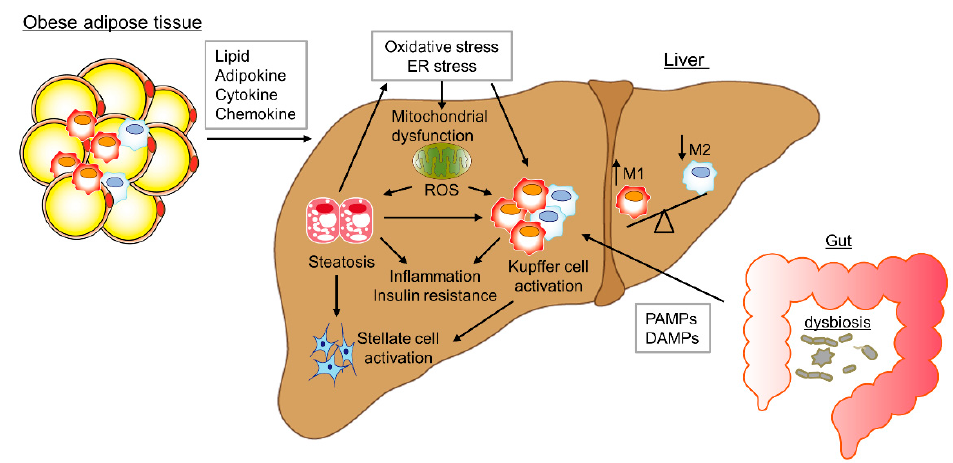
Figure 1. Multiple parallel-hit hypothesis of the progression of NAFLD/NASH. Overnutrition or inactivity caused by adipocyte hypertrophy and dysfunction. Obese adipose tissue shows chronic inflammation and insulin resistance as a result of infiltration of activated macrophages and T cells. Adipokines, such as interleukin-6 and tumor necrosis factor- α , and chemokines including CCL2 produced by adipocytes induce hepatocyte fat accumulation, hepatic inflammation, and insulin resistance. Overloading of triglycerides, free fatty acids, and free cholesterol induces endoplasmic reticulum stress and oxidative stress, leading to hepatic inflammation, mitochondrial dysfunction, fibrogenesis and, ultimately, hepatic steatosis. By contrast, microbial dysbiosis results in production of pathogen-associated molecular patterns and damage-associated molecular patterns, inducing an inflammatory response in hepatocytes, Kupffer cells, and hepatic stellate cells via a Toll-like receptor cascade, resulting in liver damage.